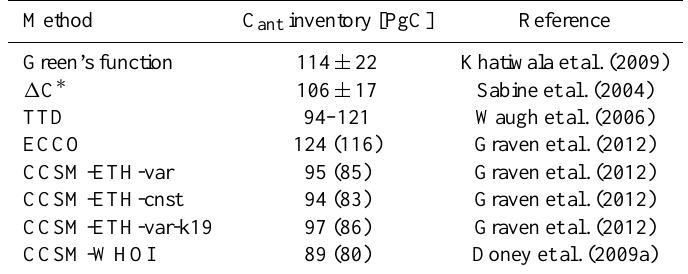
Table 1. Summary of C ant inventories in 1994 estimated by different observational methods and simulated in numerical models. For the model-based estimates, numbers in brackets represent inventories for the region covered by the GLODAP database.